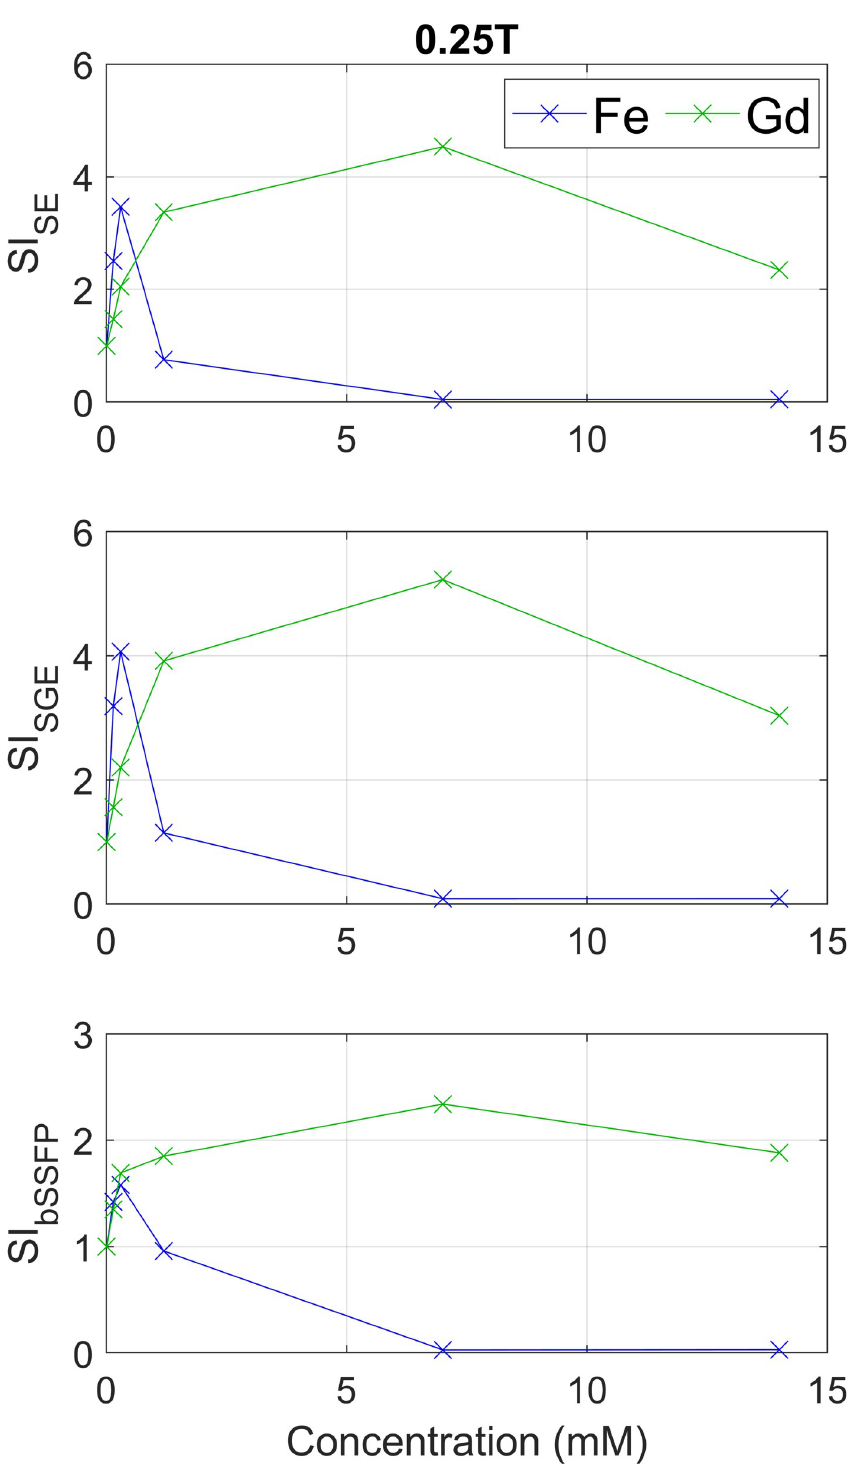
Fig 4. Measured signals (SIs) for the prepared concentrations (0–0.15–0.30–1.20–7.0–14.0 mM) for an SE, SGE, and bSSFP sequence at 0.25T. SIs are shown as normalized values as ratio to no CA (which corresponds with a value of 1). These results were compared with the normalized simulated SIs from Fig 3 (left